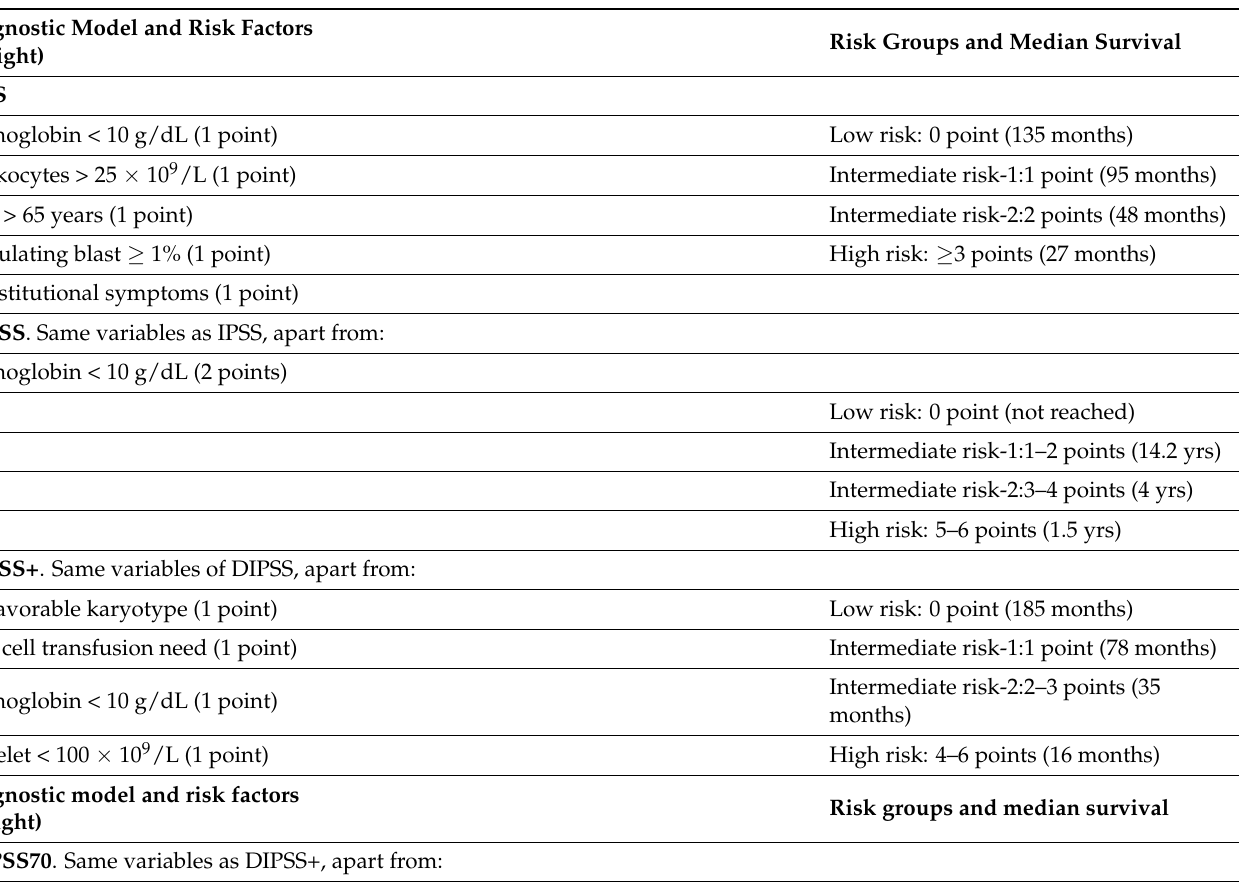
Table 1. List of prognostic scores of MPNs from the oldest to the most recent ones and with their respective genetic and/or clinical variables, the subclassification in risk groups and the respective median